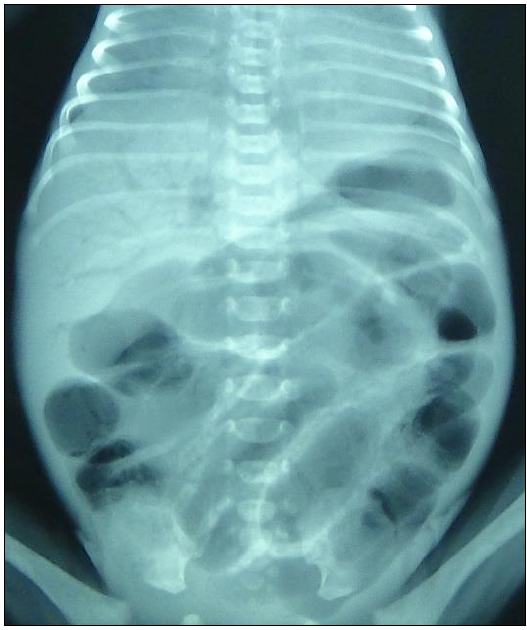
Figure 1: Gas in the portal vein